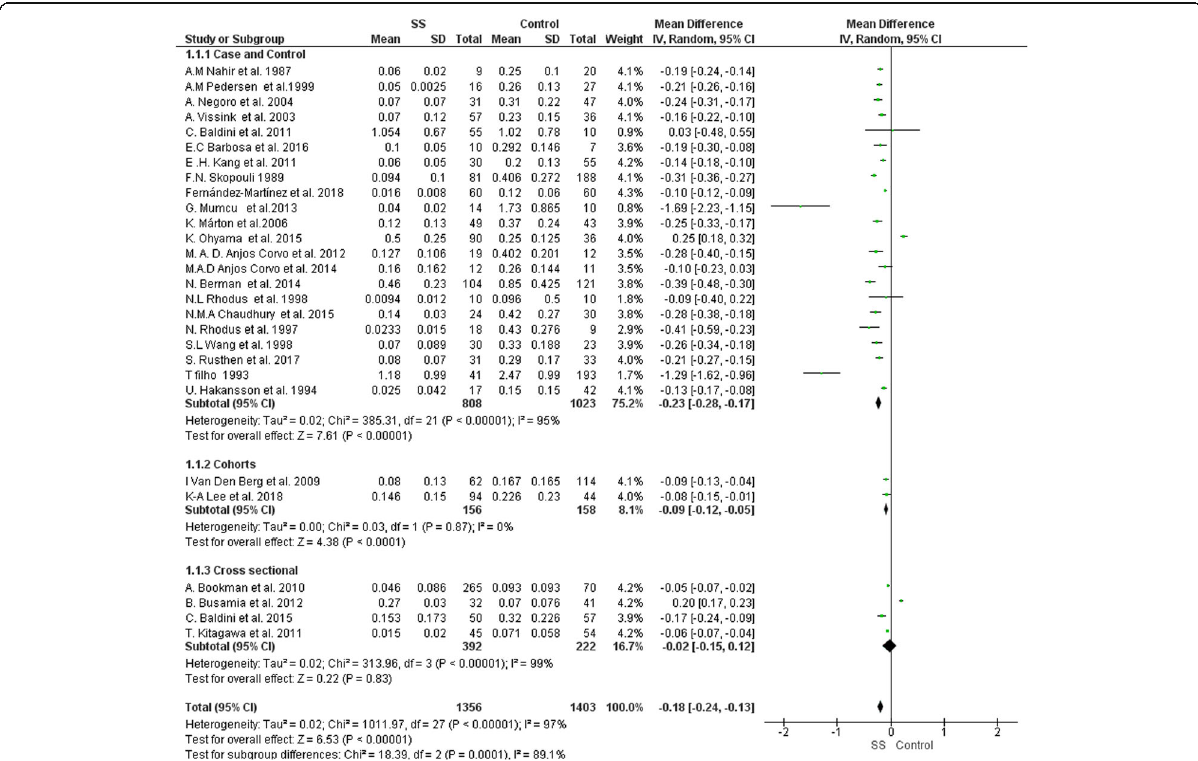
Fig. 3 Forest plot (random-effects model Mean Differences) of the unstimulated whole salivary flow rate in patients with Sjögren ’ s Syndrome compared to controls (healthy subjects and patients with sicca non-SS) by study design type. Names of the first author ’ s studies are shown on the left. CI: Confidence Interval; df: degree freedom; Chi2: chi-squared test; I2: Higgins heterogeneity test; SD: Standard deviation; SS: